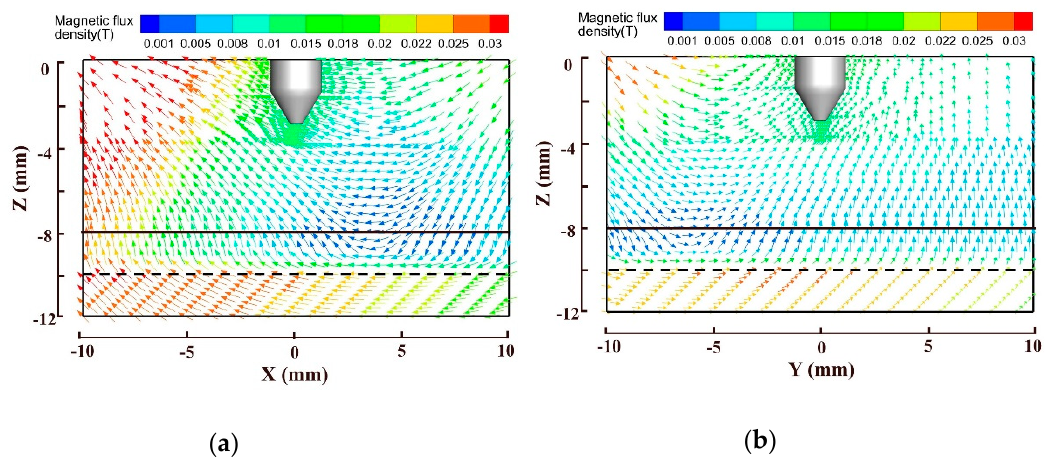
Figure 10. EMF distributions when coil 2 is energized: ( a ) xoz and ( b ) yoz planes.